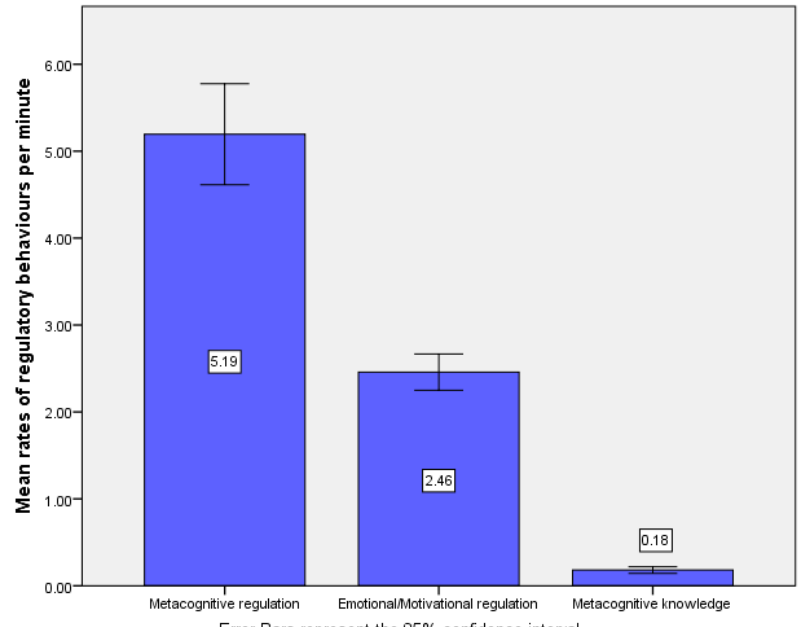
Figure 1 . Bar graph of mean rates per area of regulatory behaviour during musical